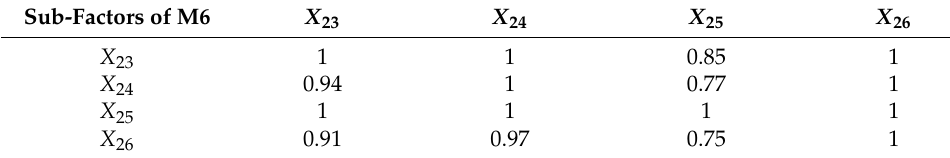
Table 13. Judgment matrix of the sub-factor layer to the upper factor M 6 .